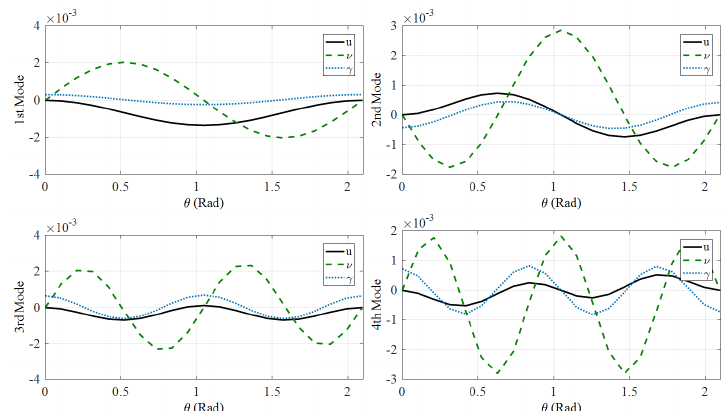
Figure 9. The mode shape of the curved beam with absorber for the first four modes (S-S)